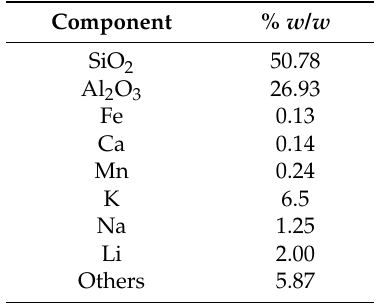
Table 1. The bulk composition of the ore by AAS and